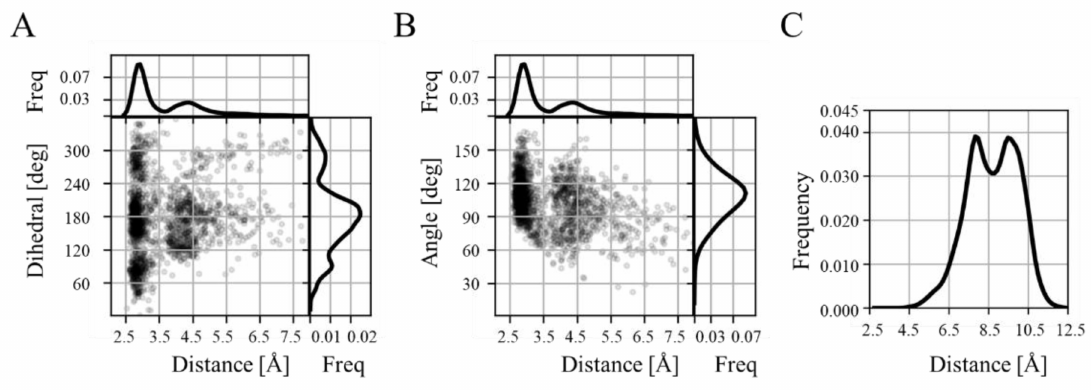
Figure 3. Structural highlights of the K417T mutation. ( A ) Distance-dihedral chart of the interaction of K417 with D30. Each dot in the plot represents the distance between K417N ζ and D30O δ and the dihedral form between C δ -C ε -N ζ of K417 and O δ of D30. ( B ) Distance-angle chart of the interaction of K417 with D30. Each dot in the plot represents the distance, as described for ( A ), and the angle form between C ε -N ζ of K417 and O δ of D30. Histograms for each single variable are presented at the edge of the chart in ( A ) and ( B ). ( C ) Histogram describing the distance between T417O γ and D30O δ